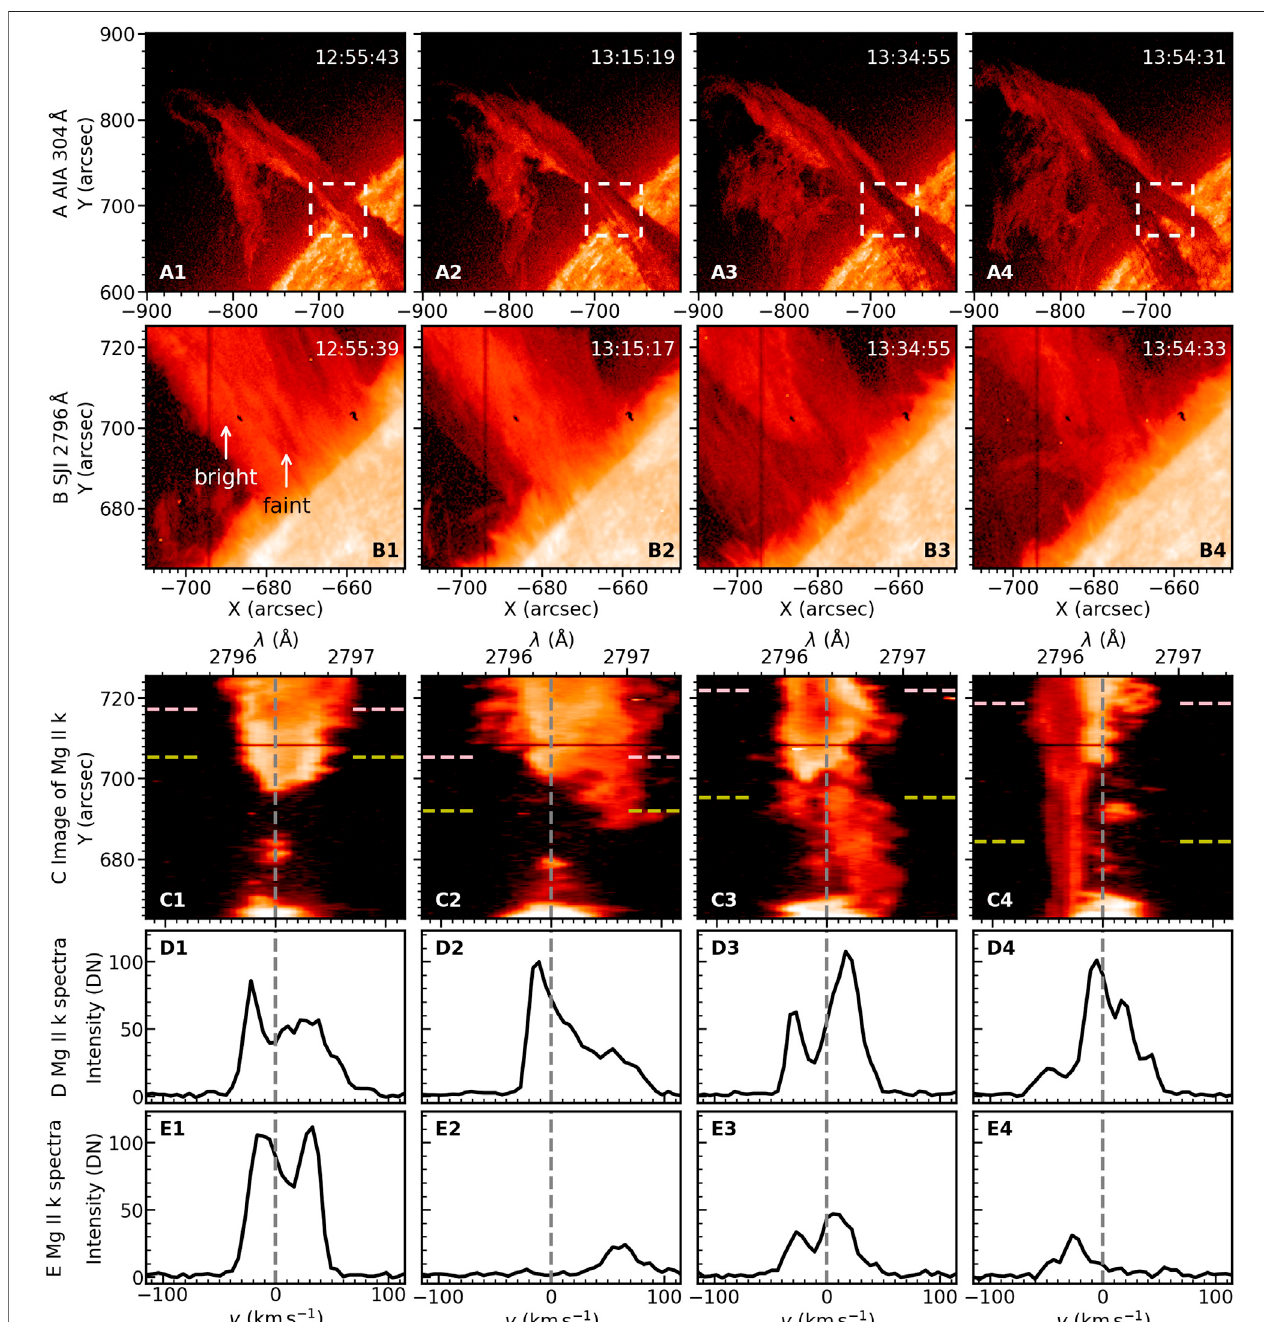
FIGURE7| AIA304 (cid:1) A andMg II kobservationsfocusingonfaintcomponents. (A) TheAIA304 (cid:1) A images.Thedashed boxesrepresenttheFOVofthesnapshotsin panels (B) . (B) The slit-jaw 2796 (cid:1) A images. (C) Images of the Mg II k spectra at the slit positions as shown in images in panels (B) . (D) Mg II k pro fi les from the positions marked with dashed pink lines in panels (C) . (E) Mg II k pro fi les from the positions marked with dashed yellow lines in panels (C) .